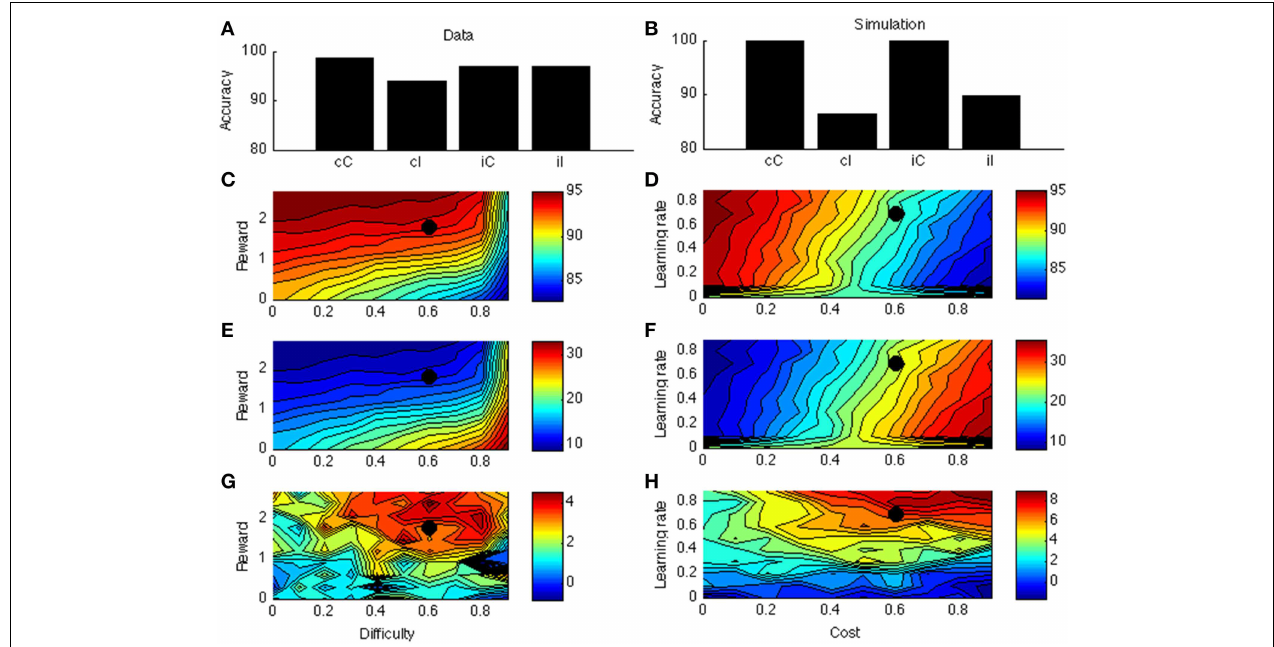
cost. (E) Simulated congruency effect across reward and task difficulty. (F) Simulated congruency effect across learning rate and cost. (G) Simulated sequential congruency effect across reward and task difficulty. (H) Simulated sequential congruency effect across learning rate and cost. Black dots in (C–H) indicate the parameter used to generate (B)